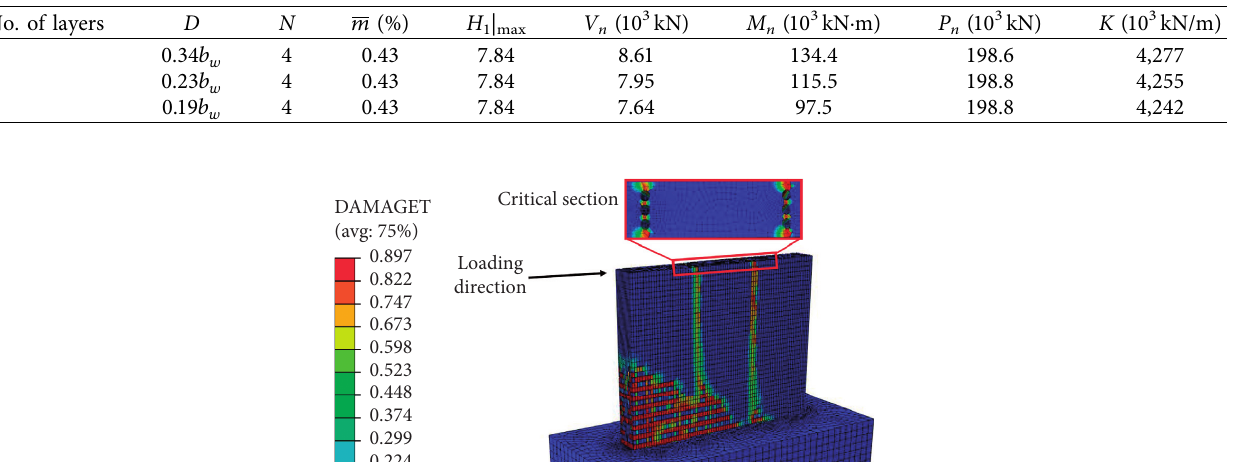
Figure 8: TLWD cross-section view of multiple-layer embedded TLMCD: (a) one-layer 4-column TLWD, (b) two-layer 4-column TLWD, and (c) three-layer 4-column TLWD. Table 6: TLWD strength performance under multiple-layer configurations.